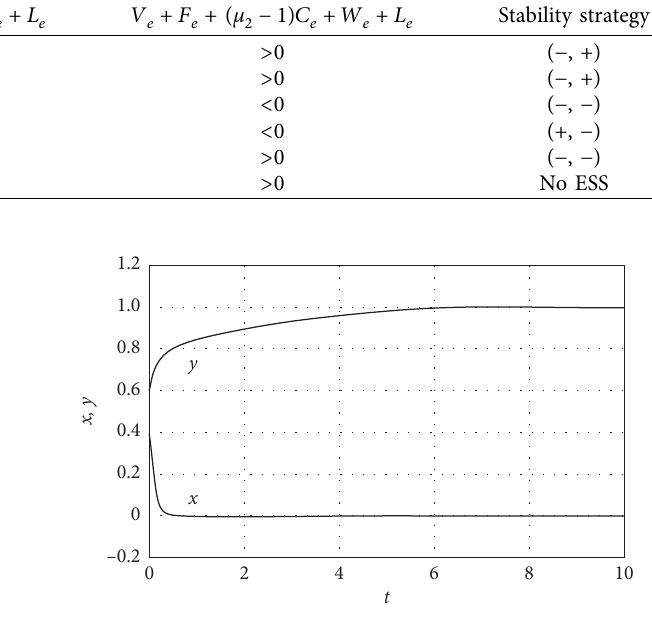
Figure 2: Dynamic evolution of government and enterprise strategy ( b ).